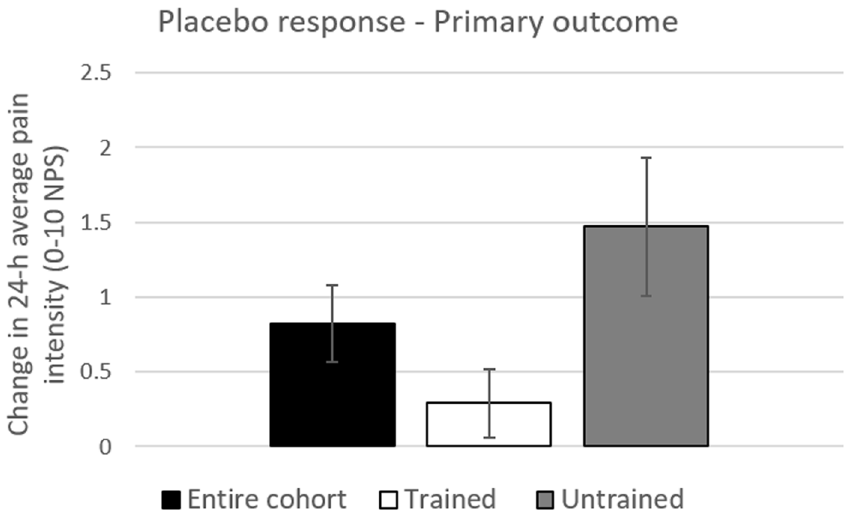
Fig 4. The placebo response in the entire cohort, trained and untrained subjects—Primary outcome measure. Change in placebo was calculated as difference between pain scores in the placebo arm (pre-minus post treatment). Black bars represent changes in pain in the entire cohort. White and Black bars represent changes in pain in the trained (n = 28) and untrained (n = 23) sub-cohorts, respectively. (cid:3) = P < 0.05; Error bars are Standard Error of the Mean (SEM).